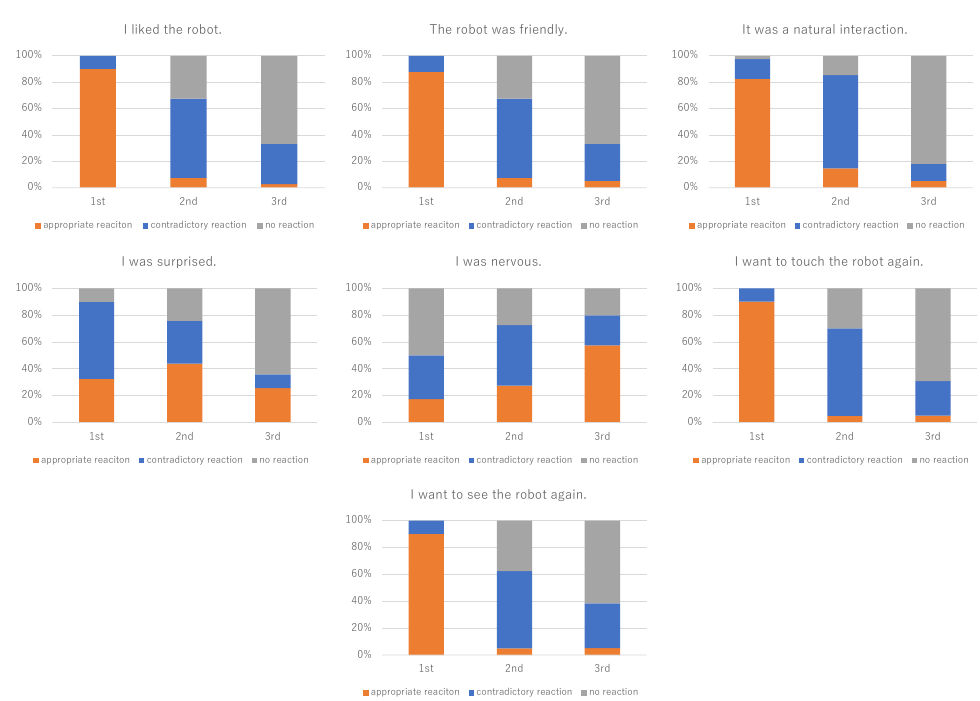
Figure 9. Results of summary questionnaire conducted after three sessions.